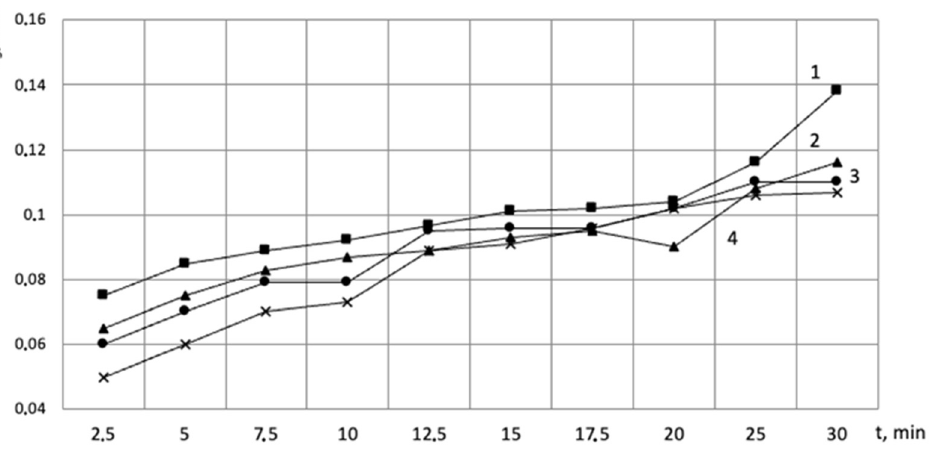
= 25 m/min. 3— V = 25 m/min.